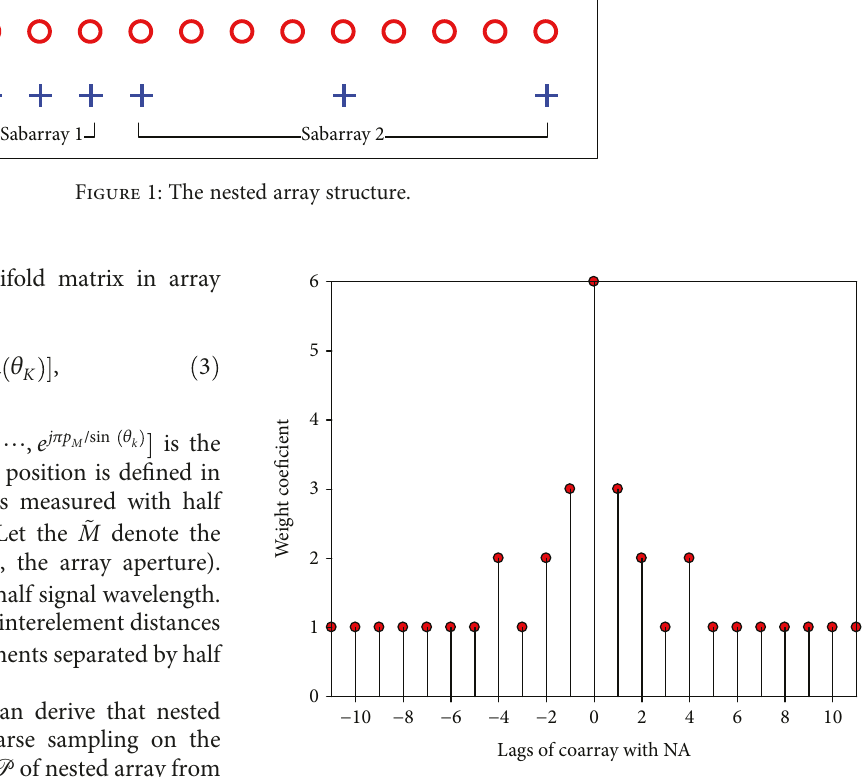
Figure 2: Weight coe ffi cient of NA coarray with six